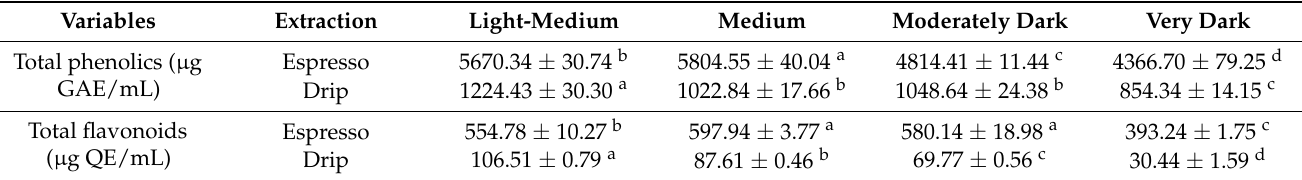
Table 3. The contents of total phenolics and total flavonoids in coffee